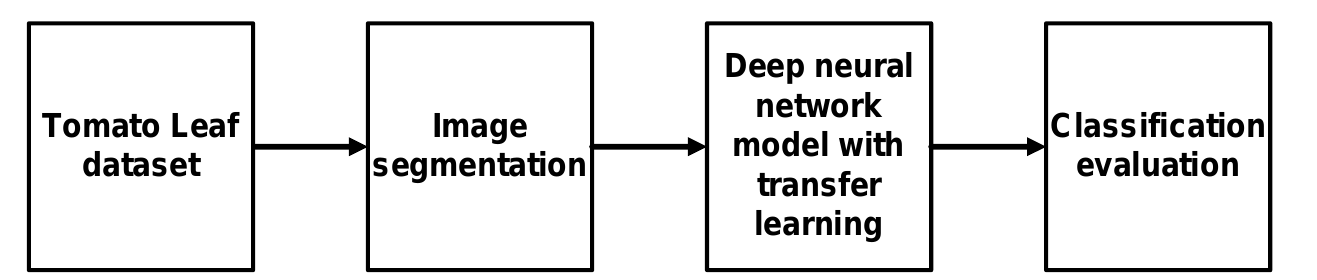
Figure 1. Proposed model for classifying tomato leaf disease and classification accuracy evaluation. 2.3. Tomato Leaf Image Segmentation Using the HSV Color